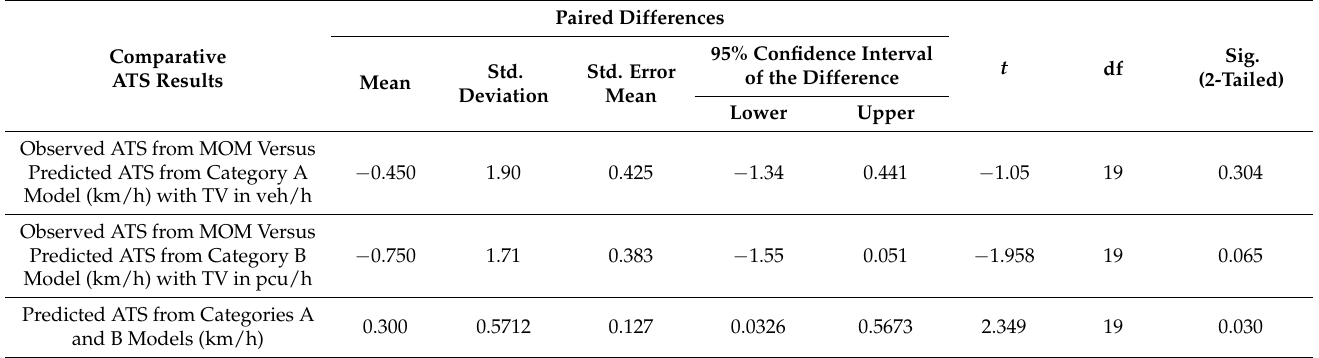
Table A1. Results of paired t -test for model of cross-sectional case of [M0, NL1, SF0].